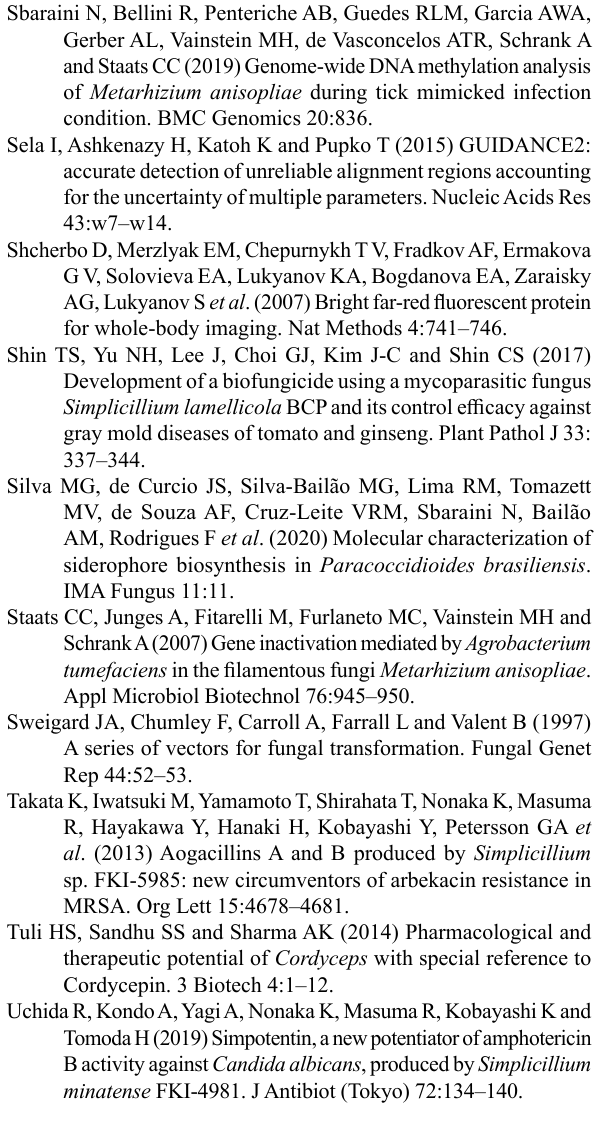
Figure S2 ‒ Confirmation of fluorescence detection in the fungal